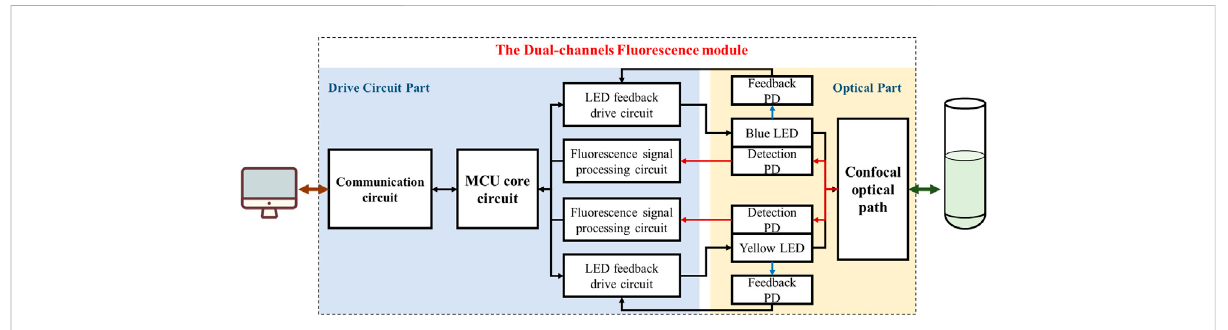
FIGURE 2 The Functional block diagram of the dual-channel fl uorescence module, which can be divided into two partitions of drive circuit and optical path (Take module 1# as an